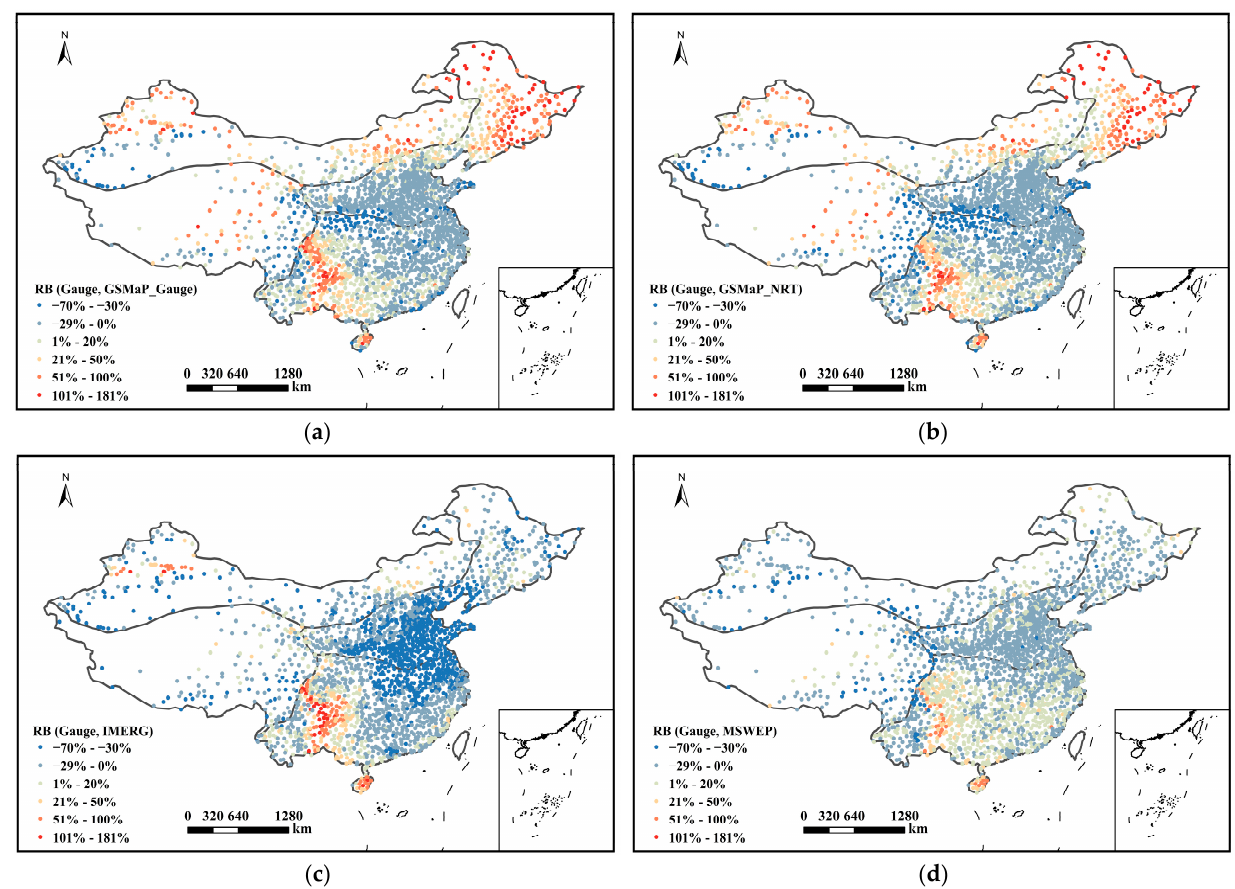
Figure 18. The spatial distribution sca tt er map of the relative bias of CDD between the gauge observations and the four SPPs: ( a ) GSMaP_Gauge, ( b ) GSMaP_NRT, ( c ) IMERG and ( d ) MSWEP.